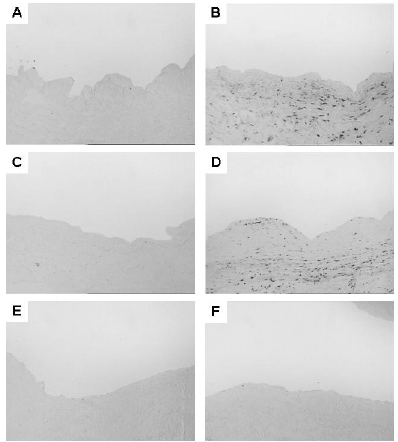
Figure 6 - TUNEL assay of human saphenous vein cultured in the ex vivo perfusion system. The segments were cultured under venous (A, C, E) and arterial (B, D, F) hemodynamic conditions for 1 (A, B) , 2 (C, D) or 4 (E, F) days. 100X magnification